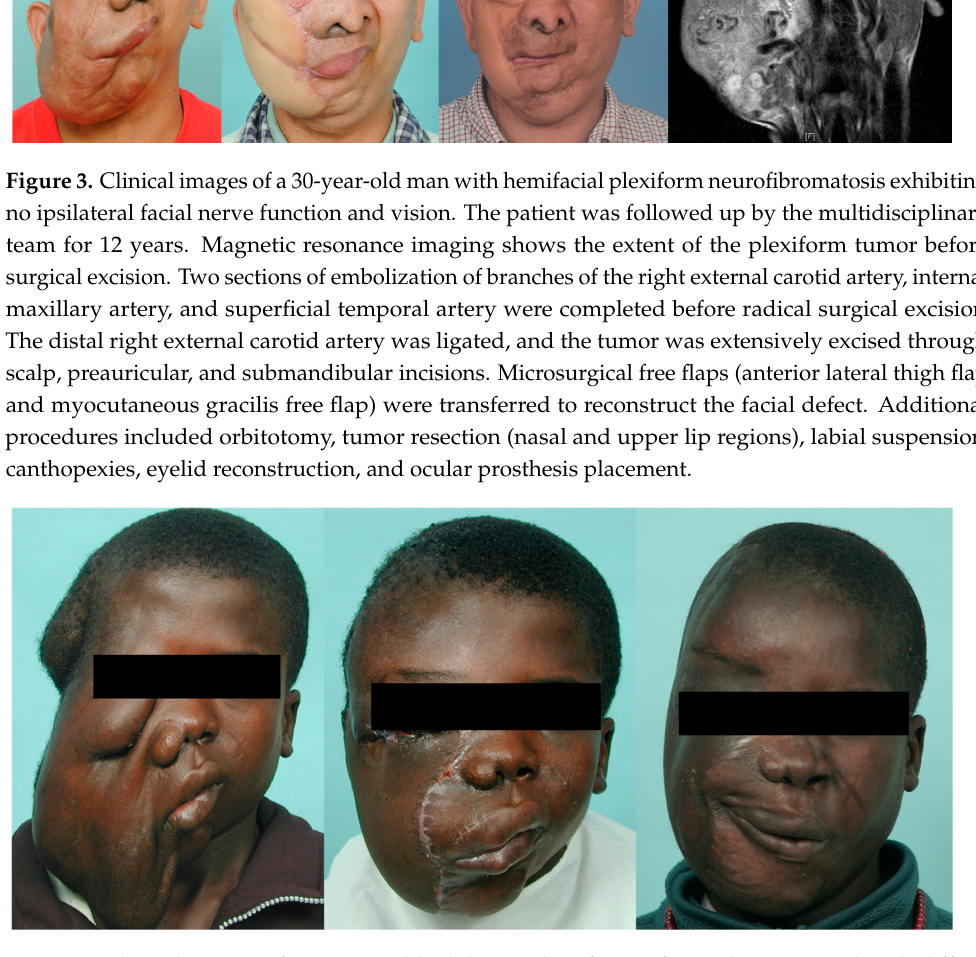
Figure 5. Clinical images of an 11-year-old boy with craniofacial plexiform neurofibromatosis who has been followed up with since the age of 2 and has been receiving orbital and zygomatic reposi- tioning and reconstruction of the orbital roof and temporal bone. Owing to the disease progression, a radical excision was performed after preoperative embolization (branches of the left internal max- illary, lingual, and facial arteries) and total interruption of the left external carotid artery. The soft tissue defect was reconstructed with an anterior lateral thigh flap. Magnetic resonance imaging showed involvement of the left intraorbital, parasellar, parapharyngeal, and posterior pharyngeal regions and adjacent disorganized brain tissues and dural ectasia; craniotomy was performed for skull base and orbital tumor removal. Additional procedures included serial tumor excisions, lip repair, and canthoplasty. Magnetic resonance imaging indicated a mediastinal mass (yellow arrow) with neck swelling, and shortness of breath had developed in recent years. An additional neurofi- broma compressing the cervical spine (C2 and C3 level) was also identified. 9. Discussion The cohort in our study exemplified the wide spectrum of NF-1 presentation, with various anatomical sites affected by tumors, causing functional and aesthetic impairments in the patients [7,22]. Because NF-1 can be expressed clinically in various manners, differ- ing even between members of the same family carrying the same NF1 mutation, treatment